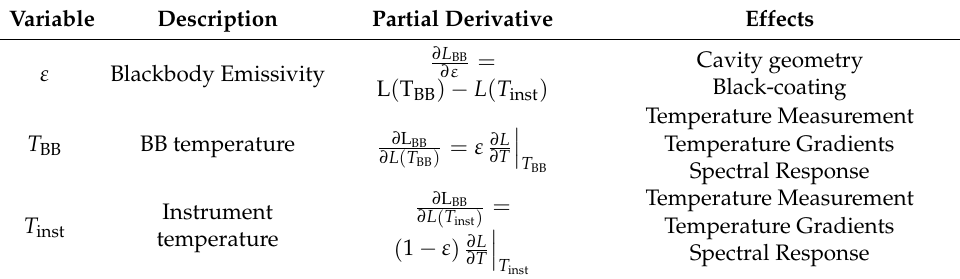
Table 2. Table of contributions to uncertainties in blackbody radiance model. Variable Description Partial Derivative